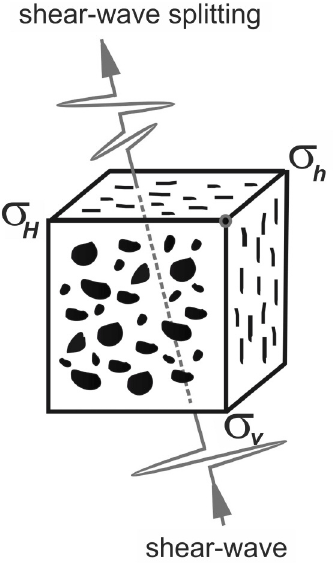
! Figure 1. Schematic illustration of shear-wave splitting on propagating through the fluid-saturated stress-aligned microcracks pervasive in most rocks in the Earth's crust [after Crampin